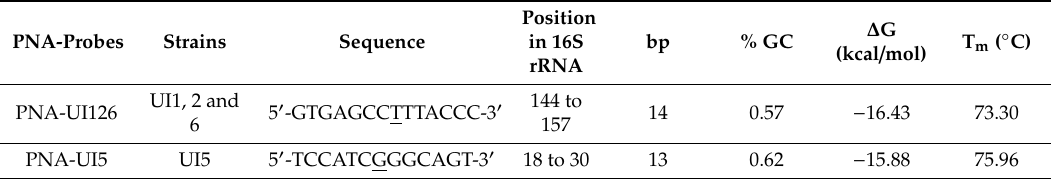
Table 1. Sequences of the PNA-FISH probes, their target positions in the 16S rRNA and theoretical values including bp (base pair), % GC, ∆ G, and T m